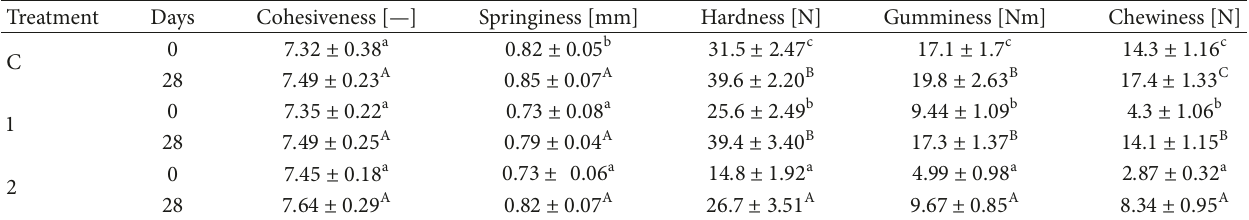
Table 2: Results of TPA test directly after production process (0 days of storage) and after 28 days of chill storage.